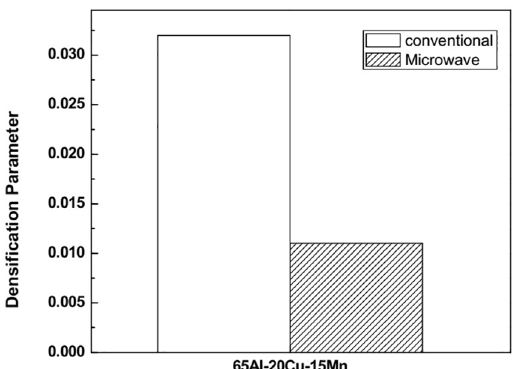
Figure 2. Densification parameter with respect to heating mode and